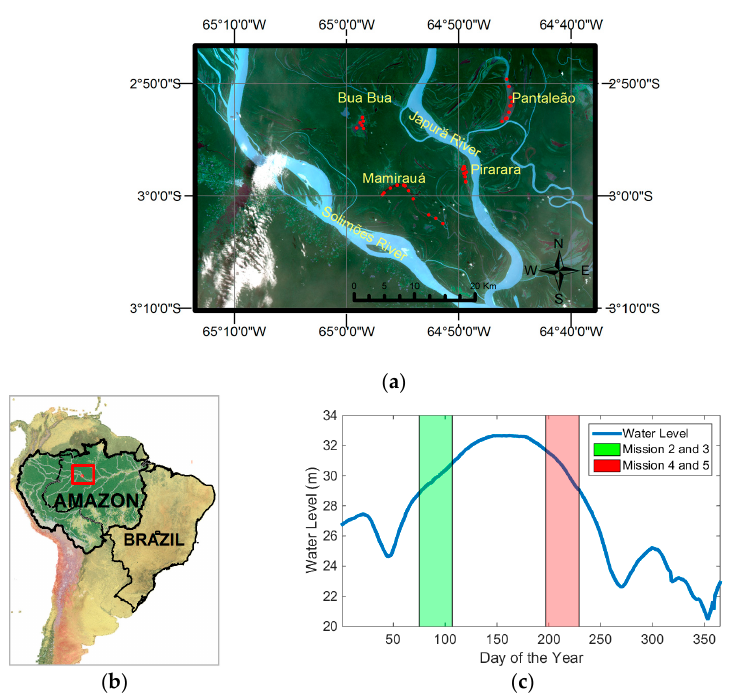
Figure 1. ( a ) OLI true color image for the study area showing the selected lakes inside the MSDR. Red dots represent the distributions of points at each lake. The image is from December 4th of 2014. ( b ) Brazil figure with RDSM location evidenced in red ( c ) Hydrograph for the year 2016, showing water level variation for missions 2, 3 (in green) 4 and 5 (in red). Mission 1 occurred in the same flood phase as missions 4 and 5 in 2015.